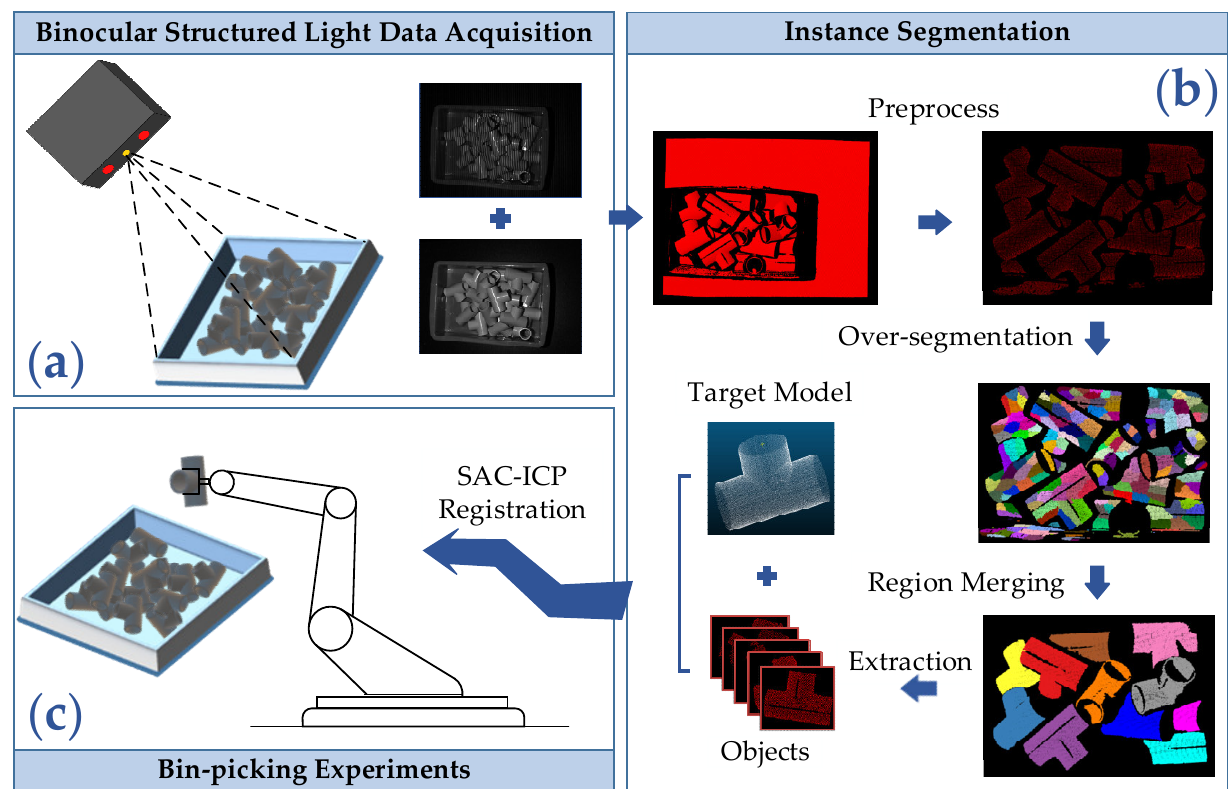
Figure 1. The process of our method and its application. Subfigures ( a – c ) display the acquisition of point cloud data, the objects instance segmentation, and bin-picking experiments, respectively.